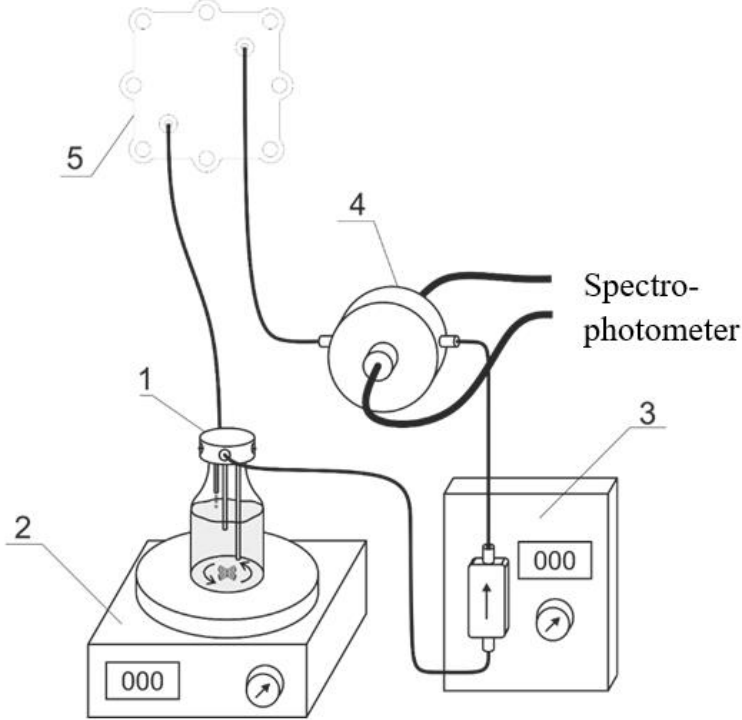
Figure 2. Experimental setup for studies of the hydrogen-bromate flow battery: tank with three con- necting pipelines (1); magnetic stirrer (2); pumping unit (3); optical flow cell with fiber optic cables (4); hydrogen-bromate flow battery (5).